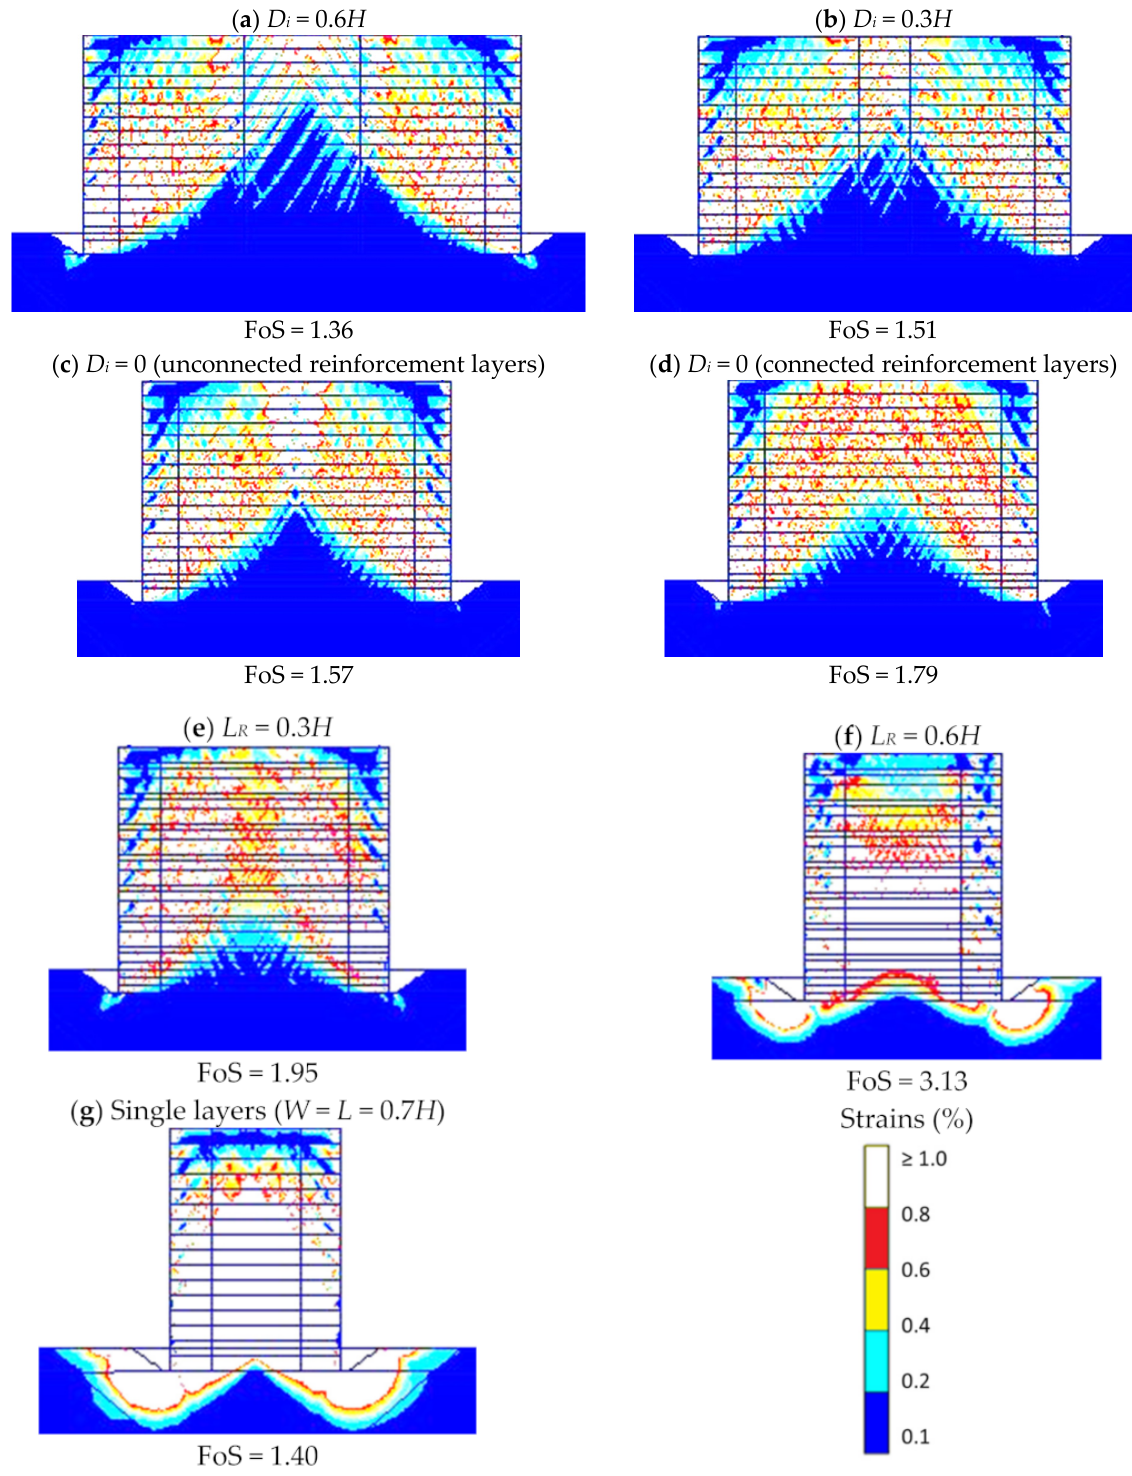
Figure 8. Shear strain contours at end of construction (EoC) for walls with different interaction dis- tance ( D i ) between the back of the reinforced soil zones for opposite walls. Note: results ranging from 0 to 1%.